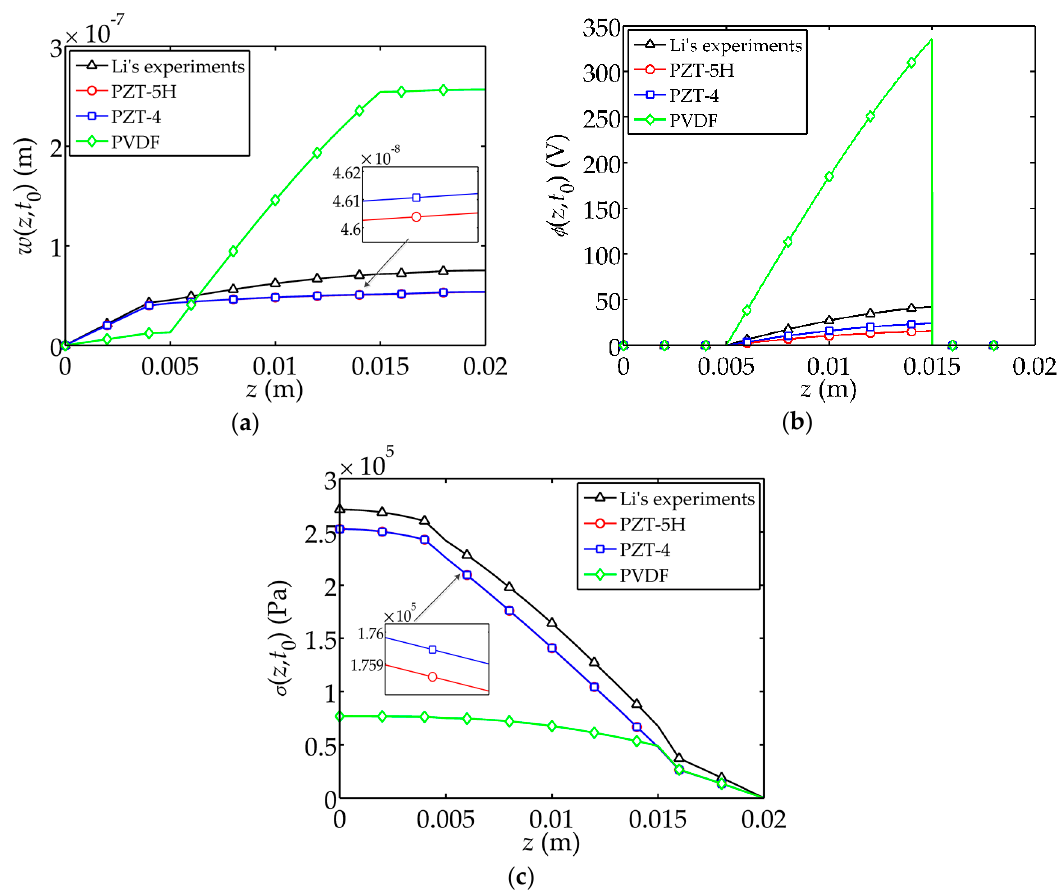
Figure 9. Influences of piezoelectric materials on the dynamic behaviors of the sensor. ( a ) Displacement w ( z , t 0 ) ; ( b ) Electric potential φ ( z , t 0 ) ; ( c ) Stress σ ( z , t 0 ) .